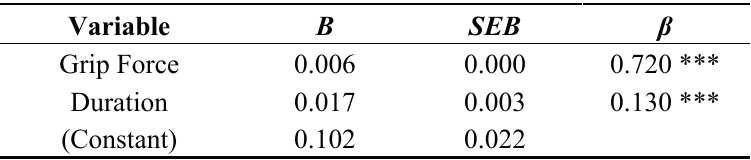
Table 7. Simultaneous multiple regression analysis summary for grip force, duration and comfort score ( N =